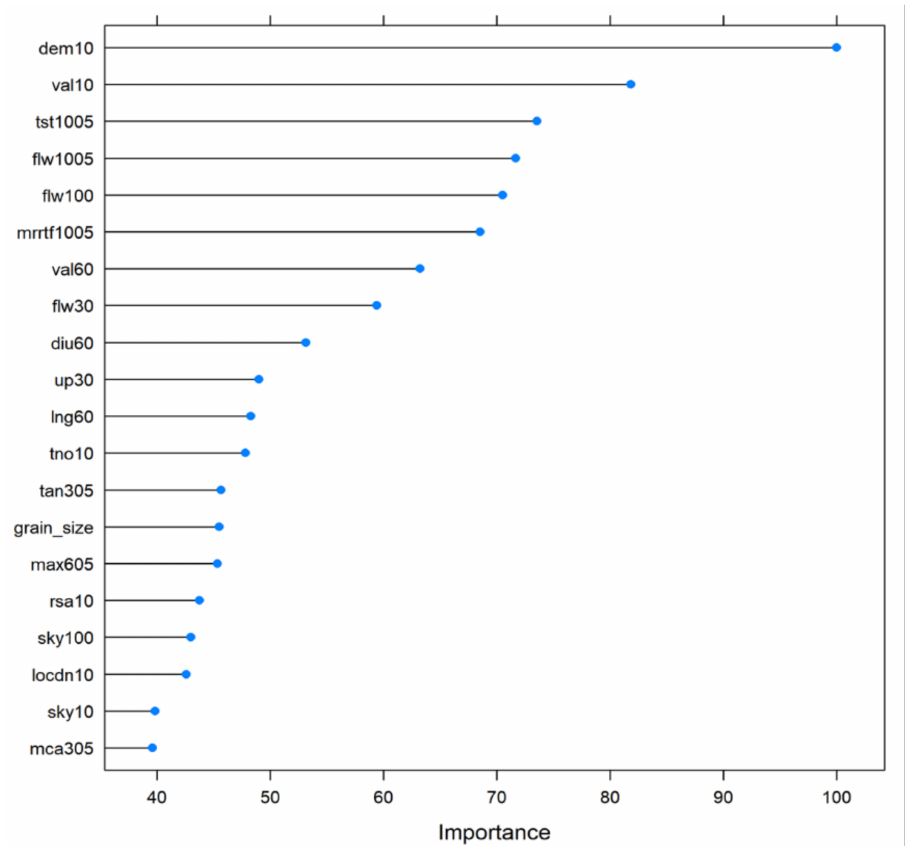
Figure 6. The RF variable importance plot highlighting the explanatory strength of the 20 most significant covariates with importance measured as decreasing from 100% (most important) to 40%. Covariate abbreviations are explained in Table